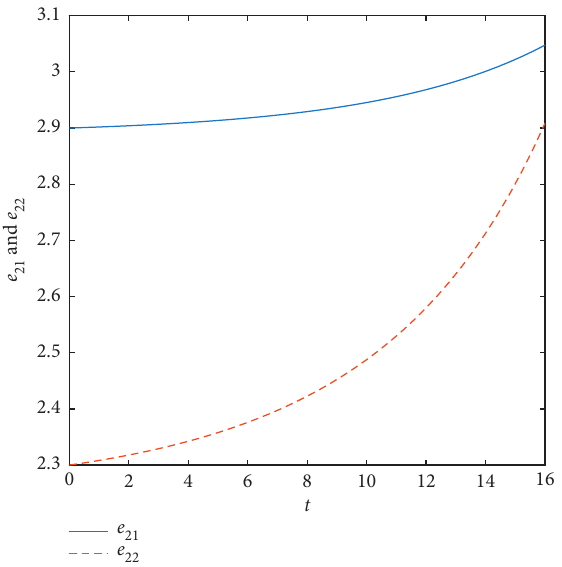
Figure 11: The pollution emission trajectory of the downstream region under cooperation.